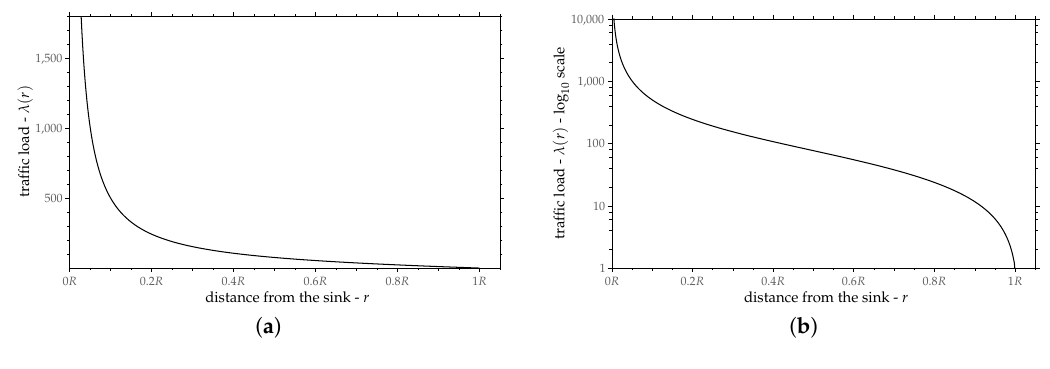
Figure 10. Traffic load versus distance from the sink as given by Equation (25), ( a ) normal plot, ( b ) semi-log (log-linear)